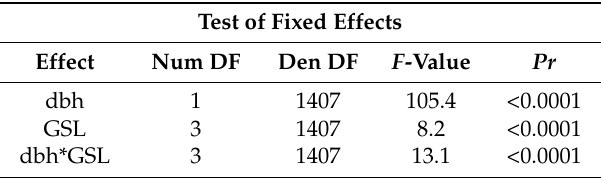
Table A4. ANOVA table for probability of attack of individual